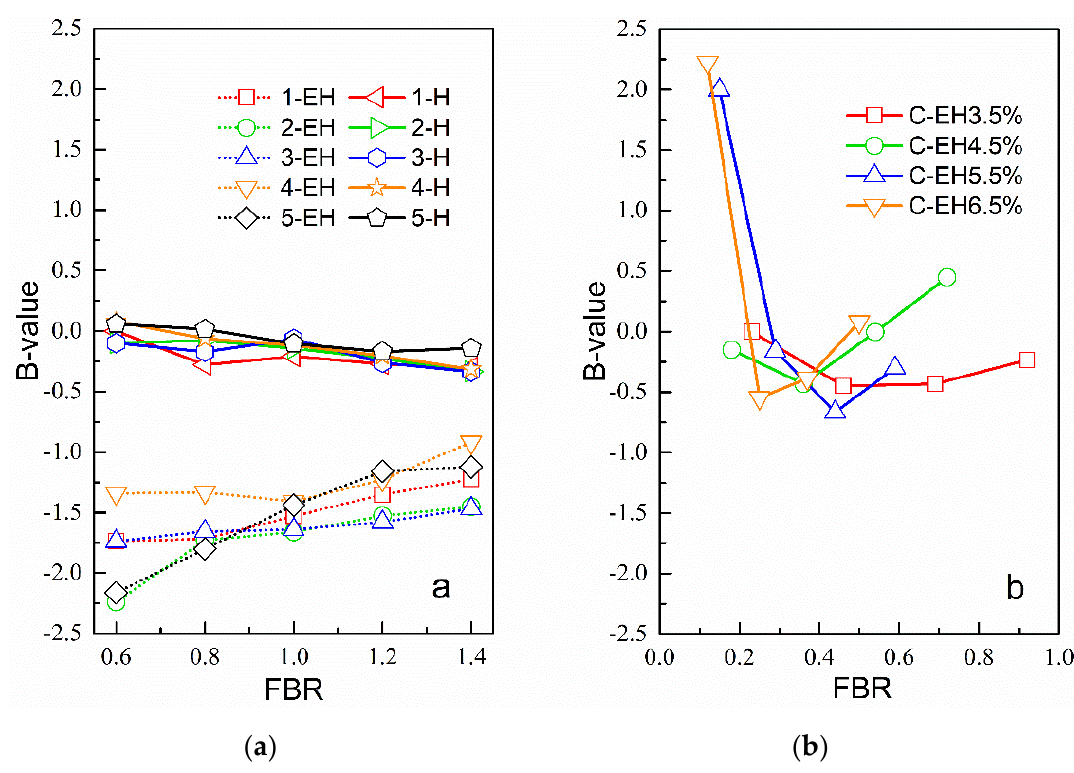
Figure 5. B-values of mastic s with ( a ) mineral filler and ( b ) cement.